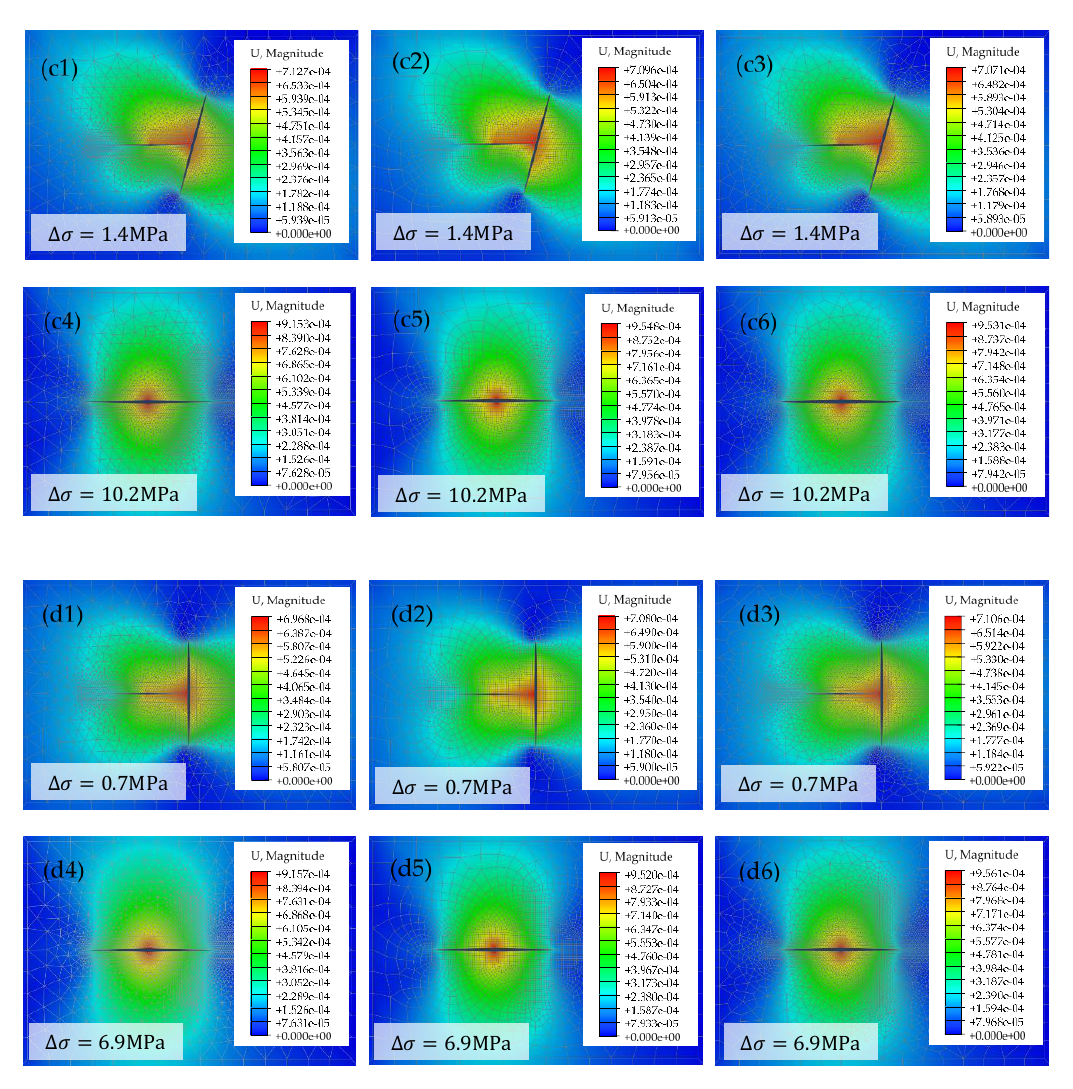
Figure 8. Comparison between numerical results with different boundary sizes and analytical results Figure 10. Results of intersection between HF and NF with di ff erent mesh types and stress contrasts. Figure 10. Results of intersection between HF and NF with different mesh types and stress contrasts. of large toughness. ( a ) Variation of fracture length with time; ( b ) fracture width at the injection point; ( a1 )–( a6 ) Intersection angle of 45 degrees; ( b1 )–( b6 ) intersection angle of 60 degrees; ( c1 )–( c6 ) intersection ( a1 ) – ( a6 ) Intersection angle of 45 degrees; ( b1 ) – ( b6 ) intersection angle of 60 degrees; ( c1 ) – ( c6 ) ( c ) pore pressure at the injection point. angle of 75 degrees; ( d1 )–( d6 ) intersection angle of 90 degrees. intersection angle of 75 degrees; ( d1 ) – ( d6 ) intersection angle of 90 degrees.